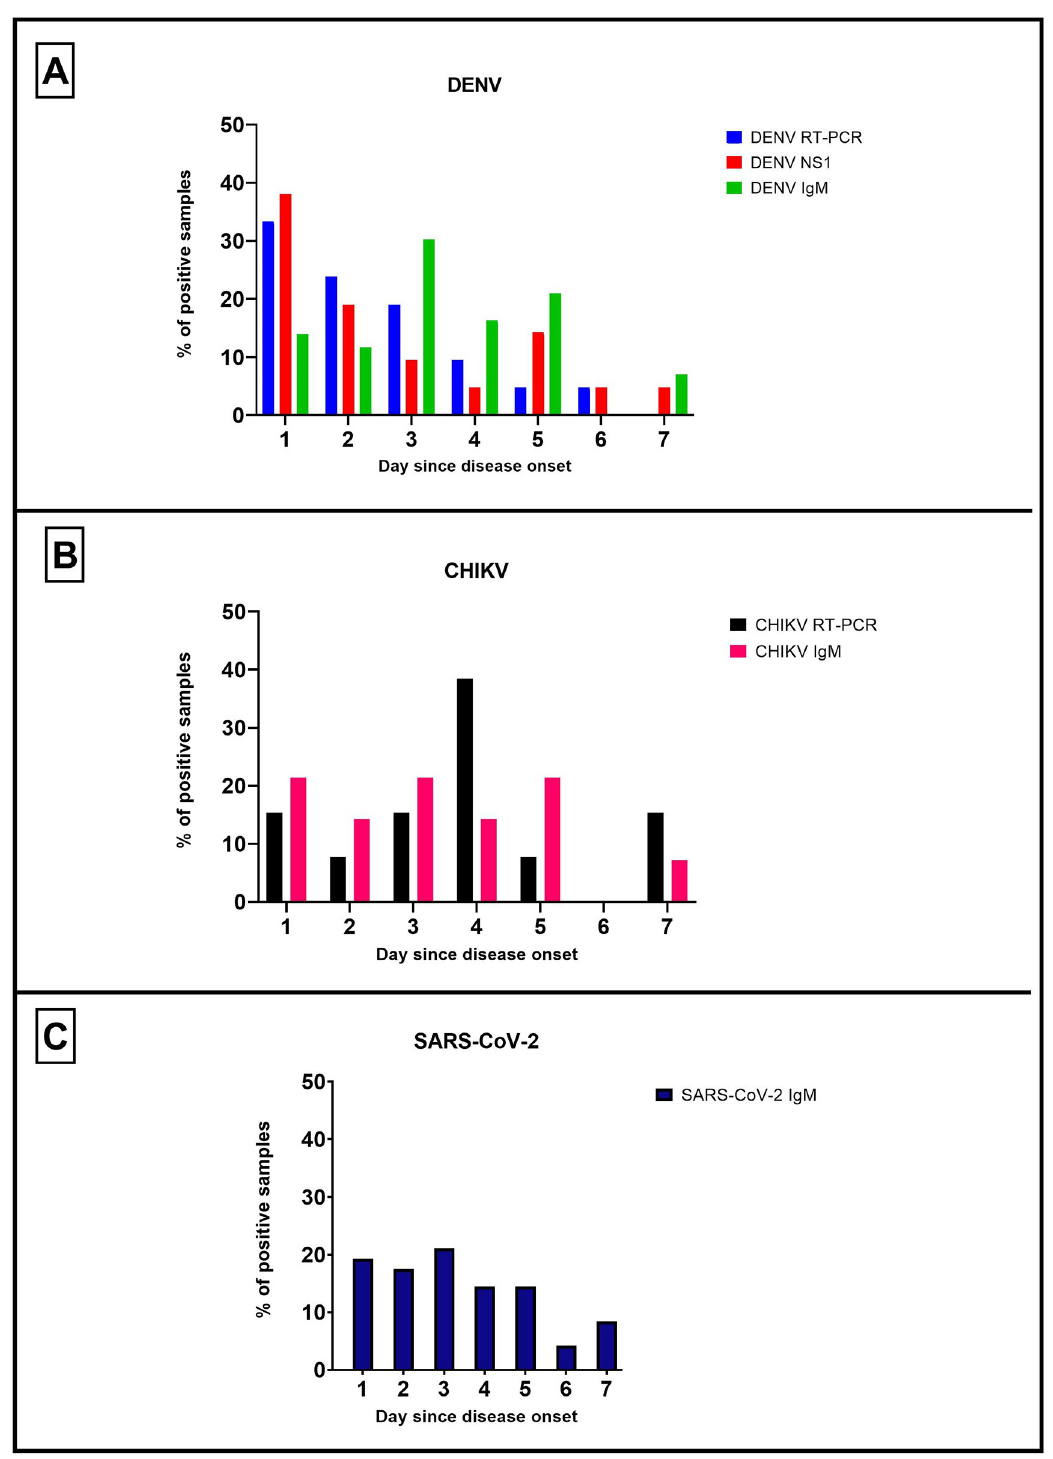
Fig 3. Performance of the different diagnostic assays according to the day of disease.